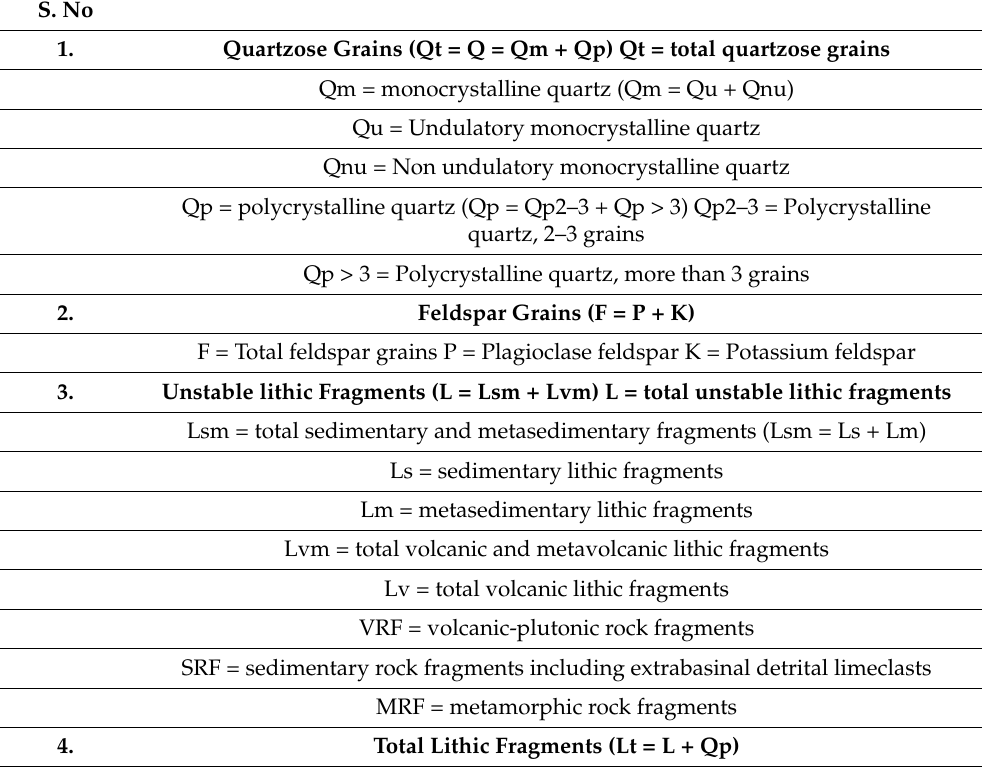
Table 3. Kuldana Formation evaluation, based on the following petrographic and other key